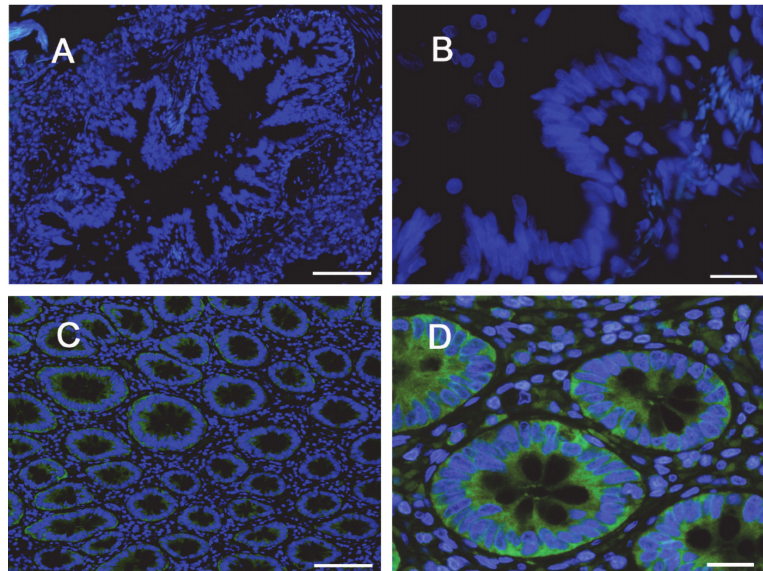
Figure 5. Immunohistochemical (IHC) detection of MDR1 in human bronchial and intestinal epithelium. Para ffi n sections of bronchus (panels A , B ) and colon (panels C , D ) specimens from healthy subjects were immunostained with anti-MDR1 antibody (green) and counterstained with